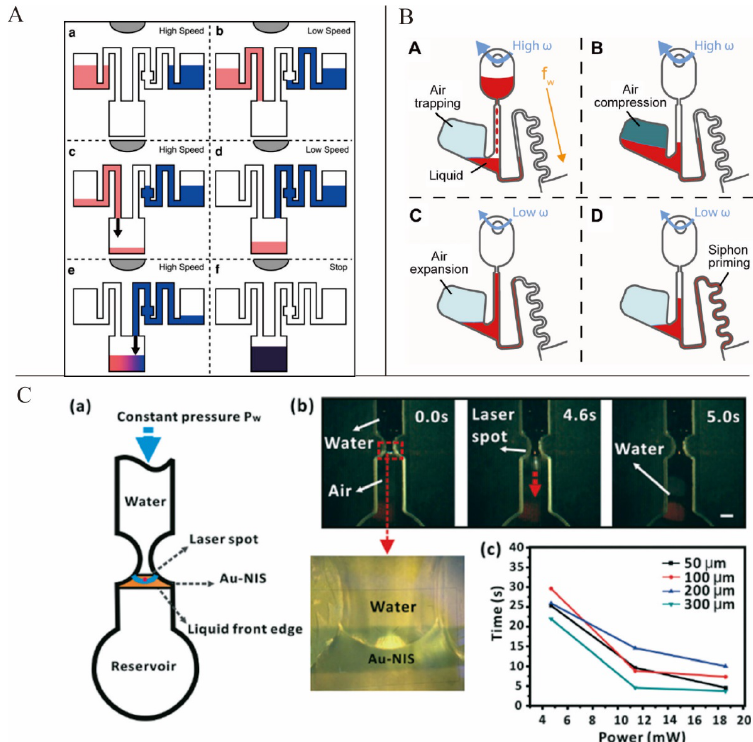
Figure 3. ( A ) Sequential loading of fluids by serial siphon valves. Figure reprinted with permission from [42]. ( B ) Centrifugo-pneumatic siphoning. Figure reprinted with permission from [44]. ( C ) Optofluidic valving. Figure reprinted with permission from [48].